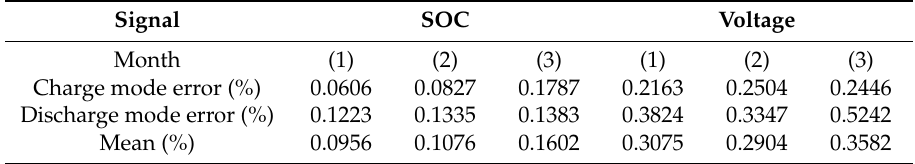
Table 5. Mean error of simulated vs. measured signals for the four-day package and three months. Signal